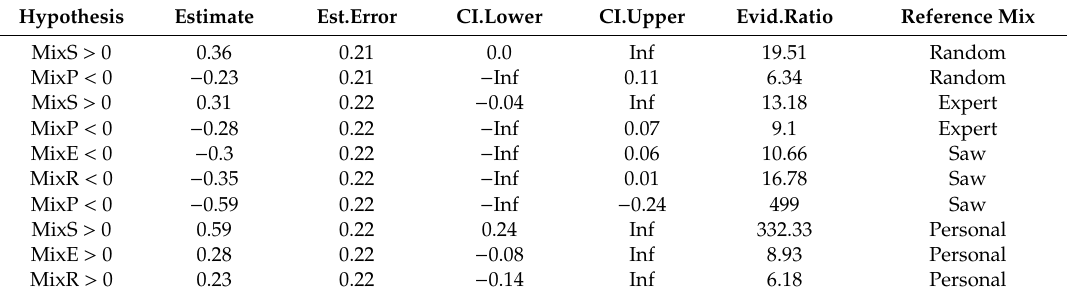
Table 1. The output of the hypothesis testing for values of the coe ffi cients of the Bayesian model is greater or smaller than 0 for any given reference mix. An Evidence Ratio of 3–10 indicates “substantial” evidence for the reported observation; Evidence Ratios of 10 + indicate strong evidence for the observation [27]. Since lower numbers for rank indicate a greater preference, negative coe ffi cients in the “estimate” column indicate a preference for the tested mix, and positive ones indicate a preference for the reference mix. Reported are results with evidence ratio ≥ 3. MixS = Sawtooth Mix, MixP = Personal Mix, MixE = Expert Mix, MixR = Random Mix, CI—Confidence